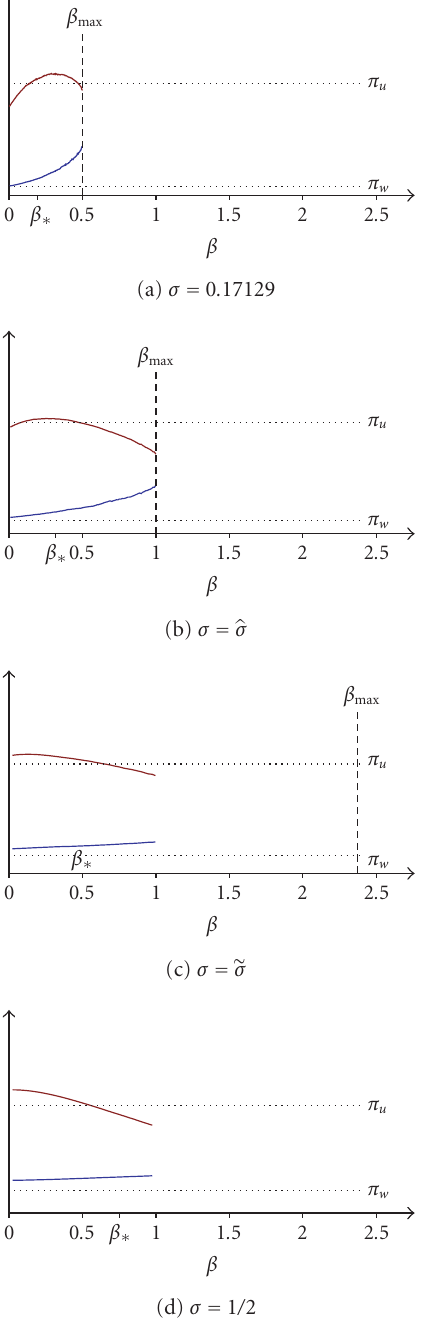
Figure 6.3. Average